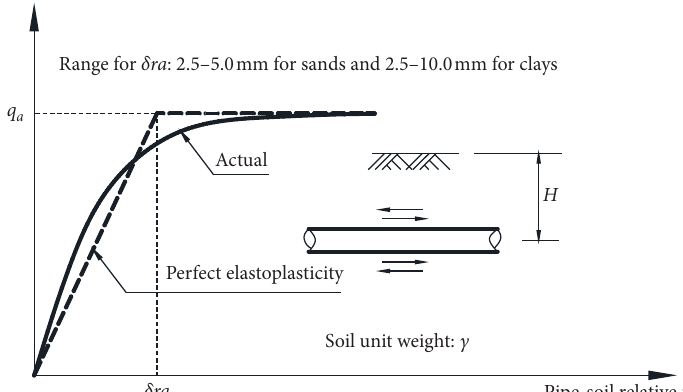
Figure 3: Force-axial relative displacement response of pipeline-soil interaction [24,